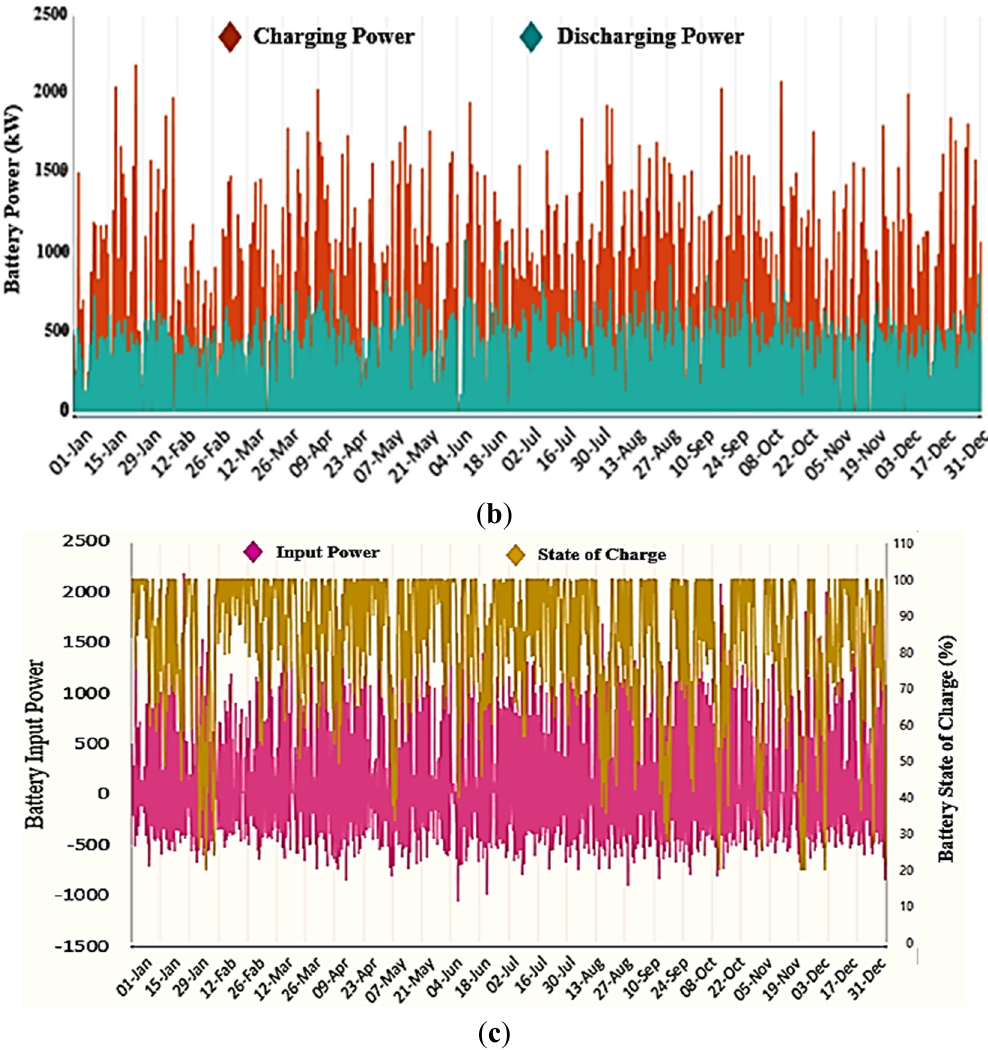
Figure 10. ( a ) The yearly battery maximum charging and maximum discharging power; ( b ) The yearly battery charging and discharging power; ( c ) The yearly batteries input power and batteries state of